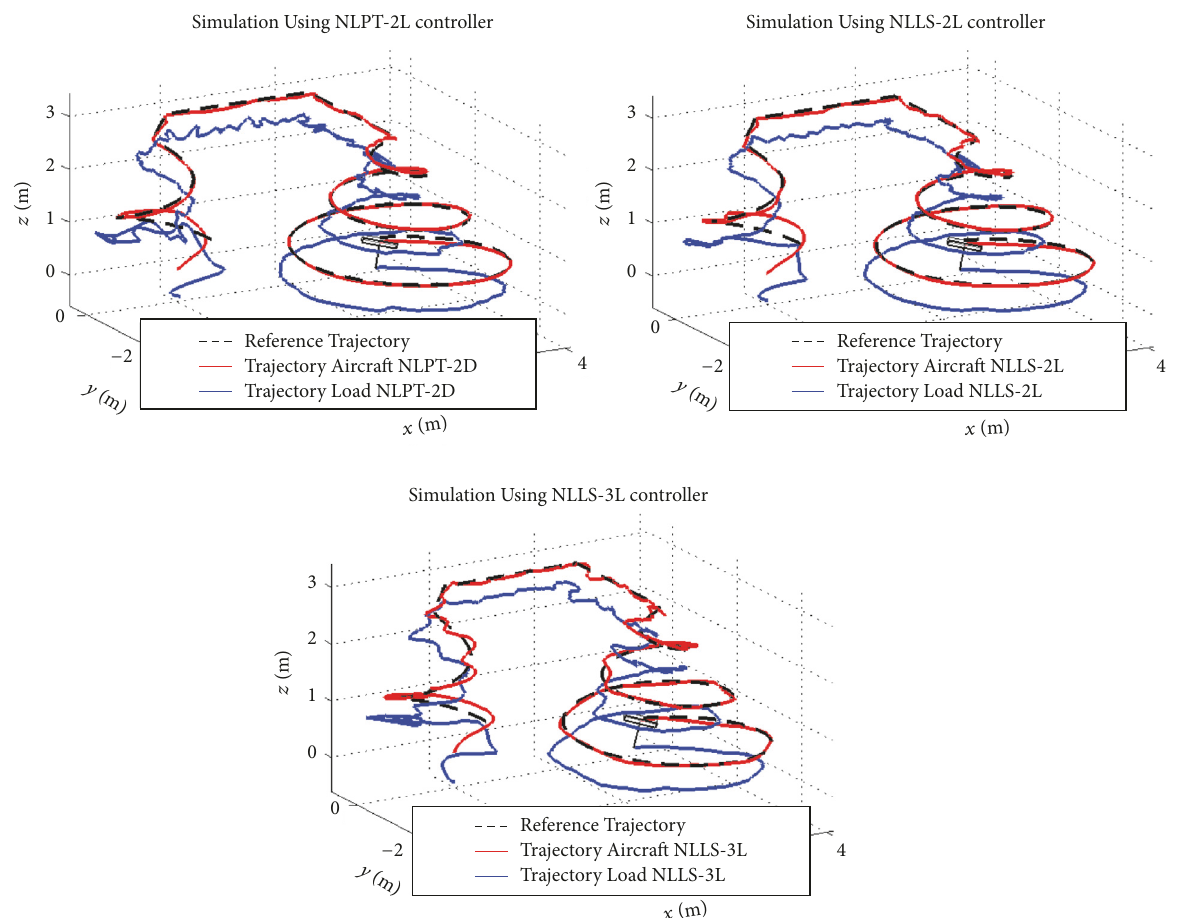
Figure 6: Trajectory tracking of the aircraft for NLPT-2L, NLLS-2L, and